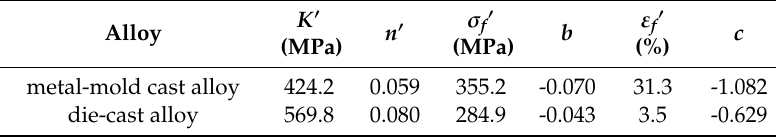
(cid:48) (cid:48) σ ε K (cid:48) f f b c n (cid:48) (MPa) (%) (MPa)